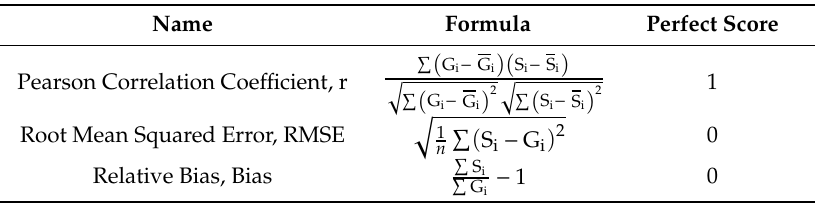
Table 2. Statistical measures (G i , rain gauge measurement; ¯G i , mean rain gauge measurement; S i ,